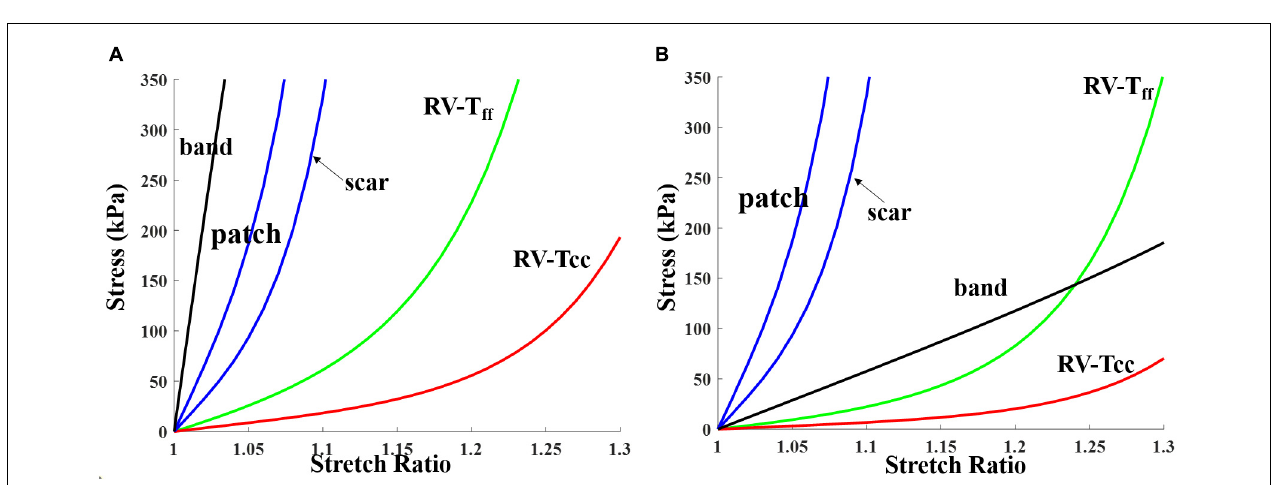
FIGURE 5 | Stress-stretch curves for patch, scar, band, and myocardium tissue for RV inner layer (patient 5). Material parameter values are given in Table 3 . (A) End systole. (B) End diastole. RV-T ff , RV stress in fiber direction; RV-T cc , RV stress in direction perpendicular to fiber